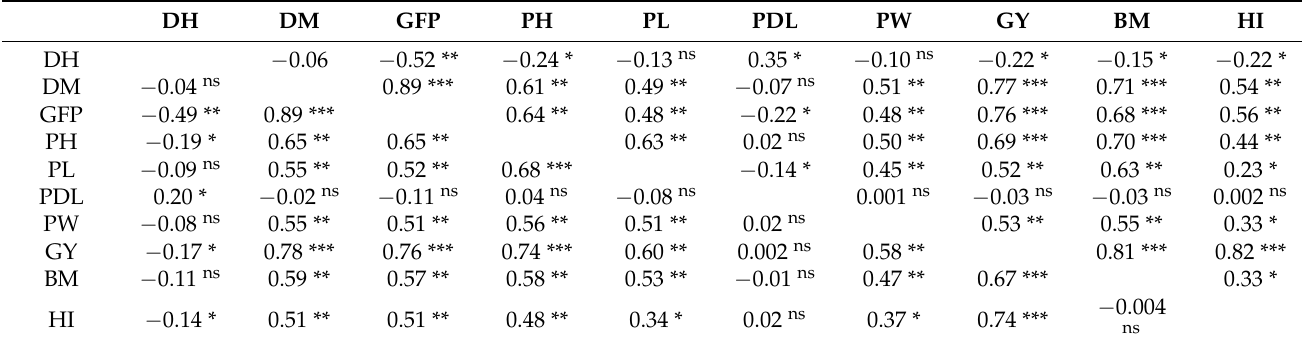
Table 5. Genotypic (above diagonal) and phenotypic (below diagonal) correlation coefficients between the important traits of 317 teff genotypes under the intensive growing condition.